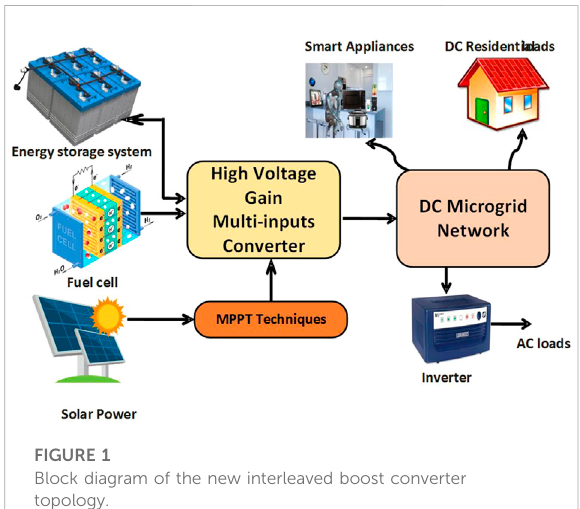
FIGURE 1 Block diagram of the new interleaved boost converter